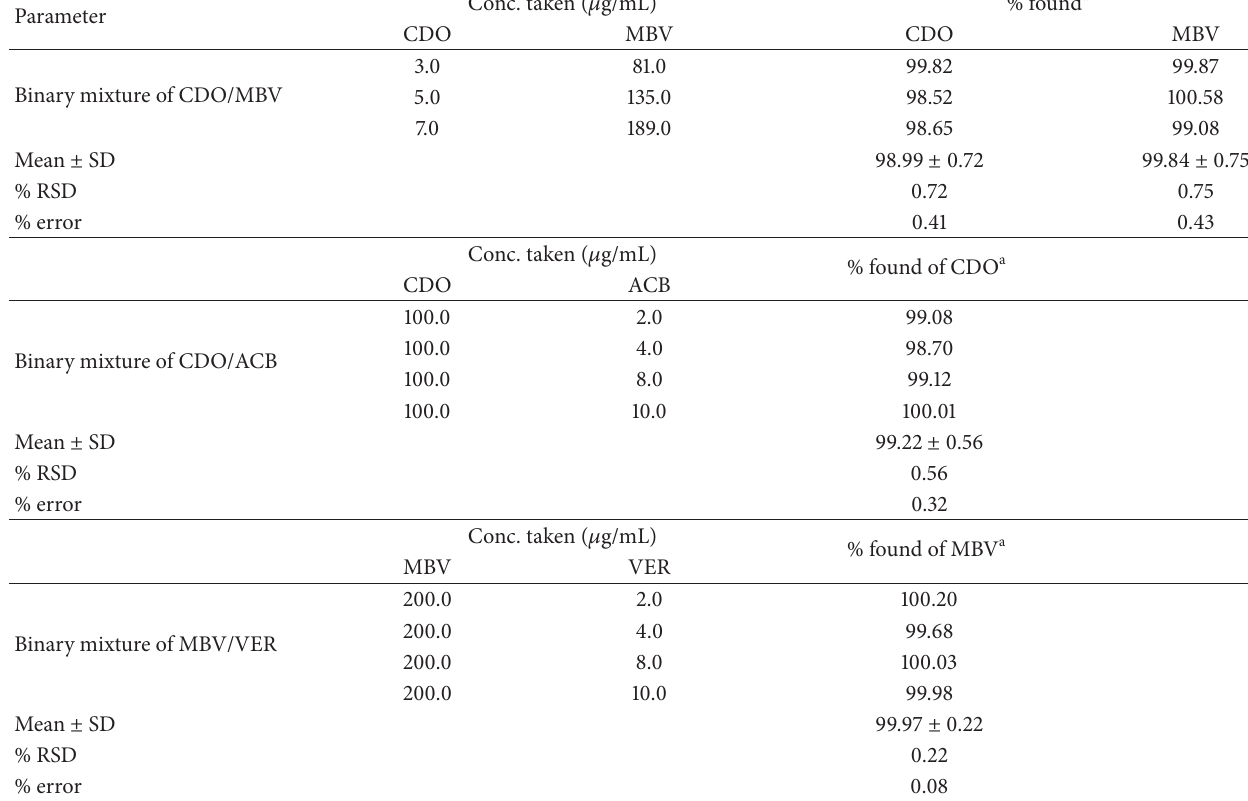
Table 4: Application of the proposed method for the determination of CDO, MBV, and their degradation products in binary mixtures. Conc. taken ( 𝜇 g/mL) Parameter